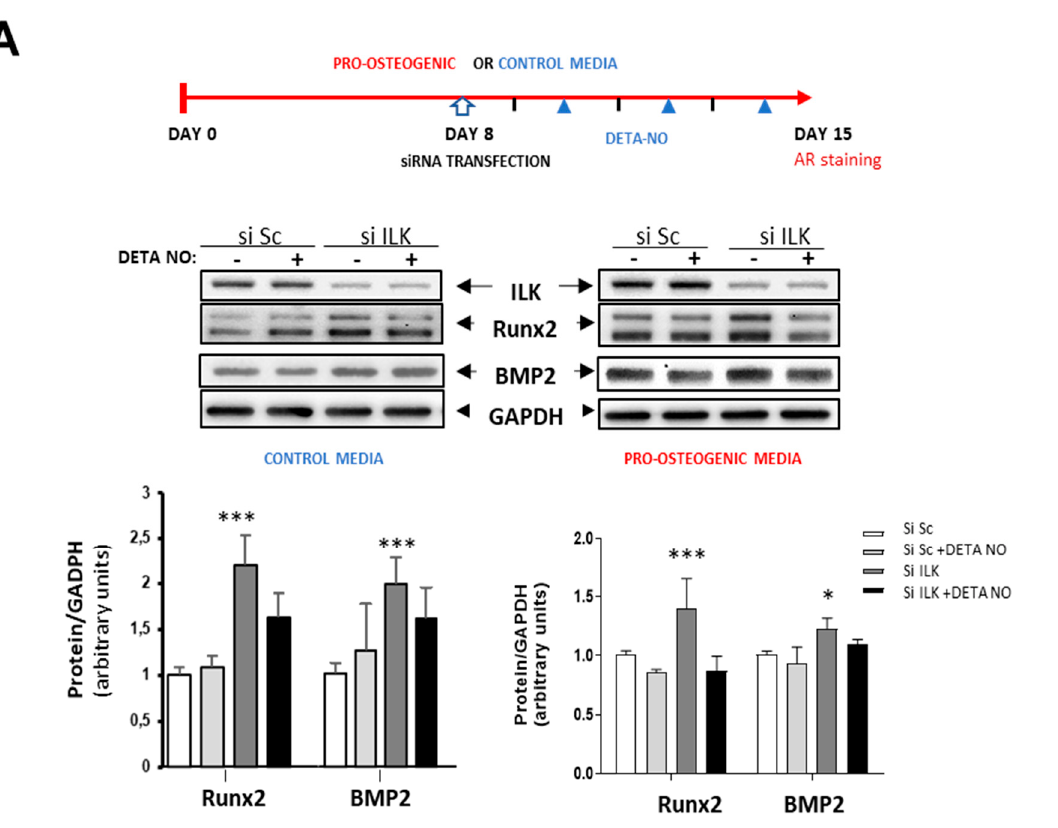
Figure 4. NO reverses the osteogenic phenotype induced by ILK silencing in hVECs. ( A ) Top: Scheme of the experimental design. Below: Western blot analysis (left) and quantification (right) of RUNX2 and BMP2. n = 8. * p < 0.05; *** p < 0.0001. ( B ) Alizarin Red staining. hVECs cultured with control medium or pro ‐ osteogenic medium for 15 days were transfected with siSc or siILK for the last 7 days and treated with DETA ‐ NO for 7 days. DETA ‐ NO treatment was replenished every other day. Scale bar = 100 μ m. Below: Quantification of alizarin red positive area. n = 6. Pro ‐ calcific me ‐ dium: *** p < 0.0001 vs. Si Sc; ## p < 0.001 vs. Si ILK.